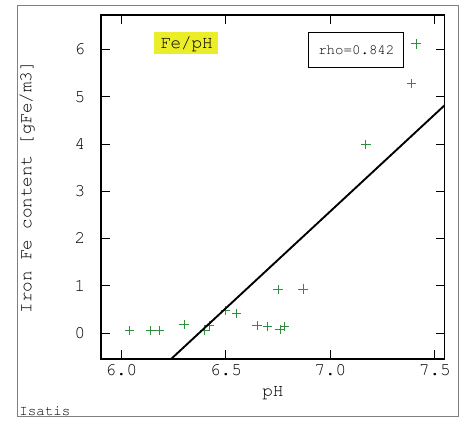
Fig. 13. Diagram correlation of iron Fe ++ content [g Fe ++ /m 3 ] and temperature  C [degrees] in underground water, with the marked regression line Y / X in the area of water intake in the region of Kłodzko (14 wells)